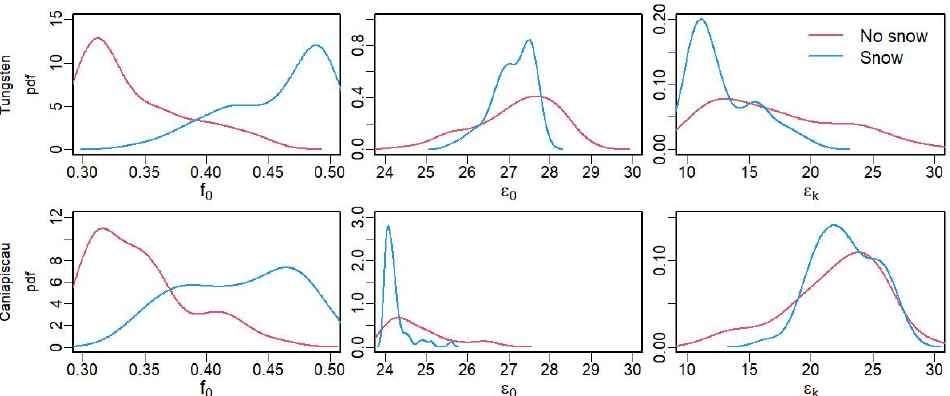
Figure 7. Posterior probability density distributions of the parameters controlling δ 18 O TRC at the Tungsten and Caniapiscau sites, for the model without (red) and with (blue) snow.